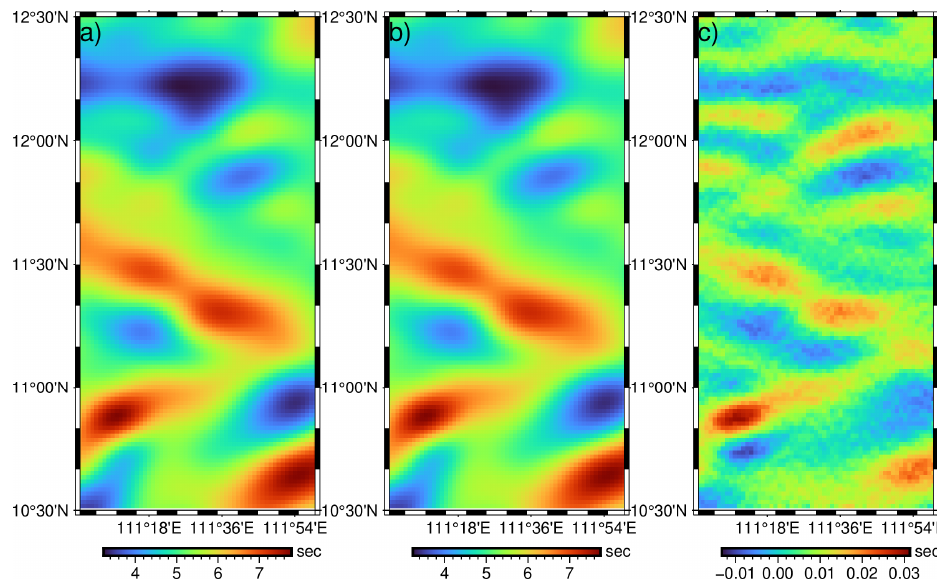
Figure 5. North-south component of DV: ( a ) true value; ( b ) recovered value; ( c ) error.